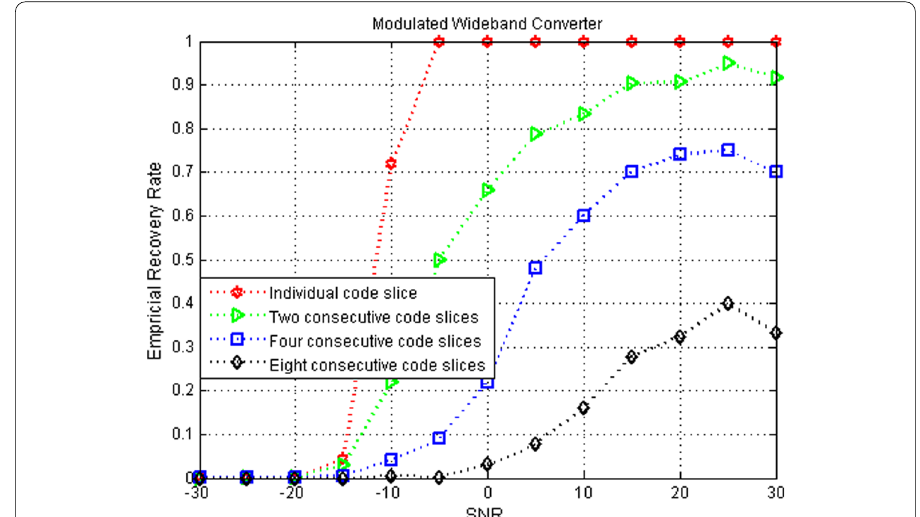
Fig. 13 Percentage of correct support recovery in MWC, when m = 60